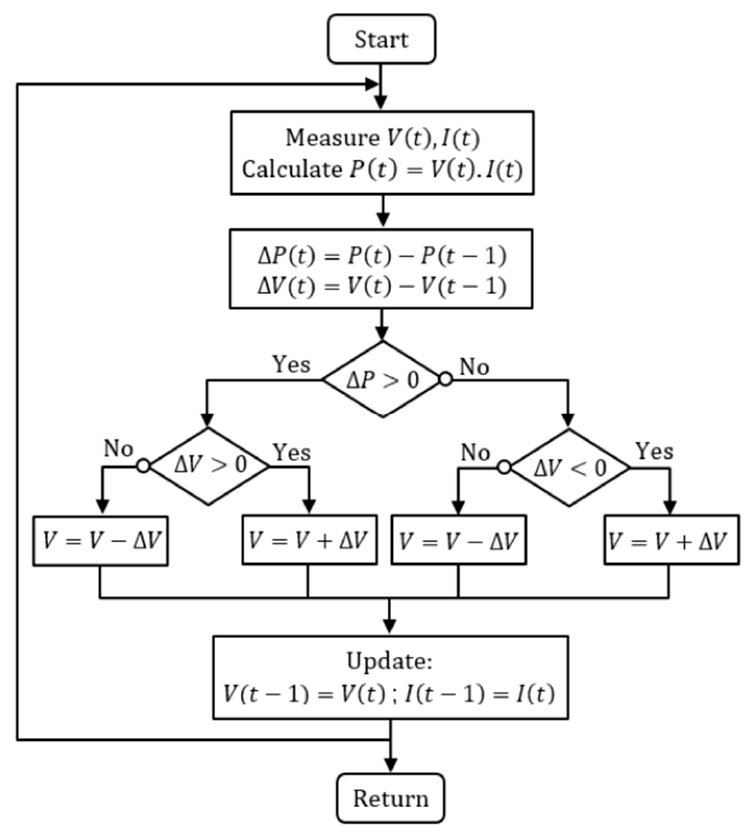
Figure 6. P and O algorithm flowchart.